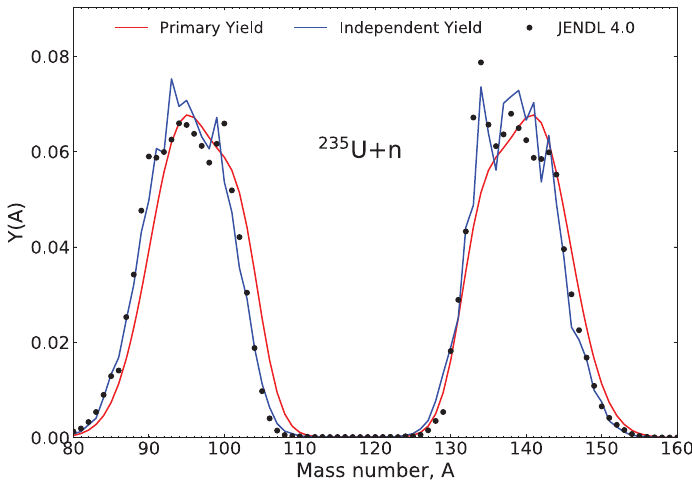
Figure 3. The calculated independent fission yield (blue) after statistical de-excitation of the nascent fragments (red) for the thermal neutron induced fission of 235 U. Calculations compared to JENDL-4 [26,